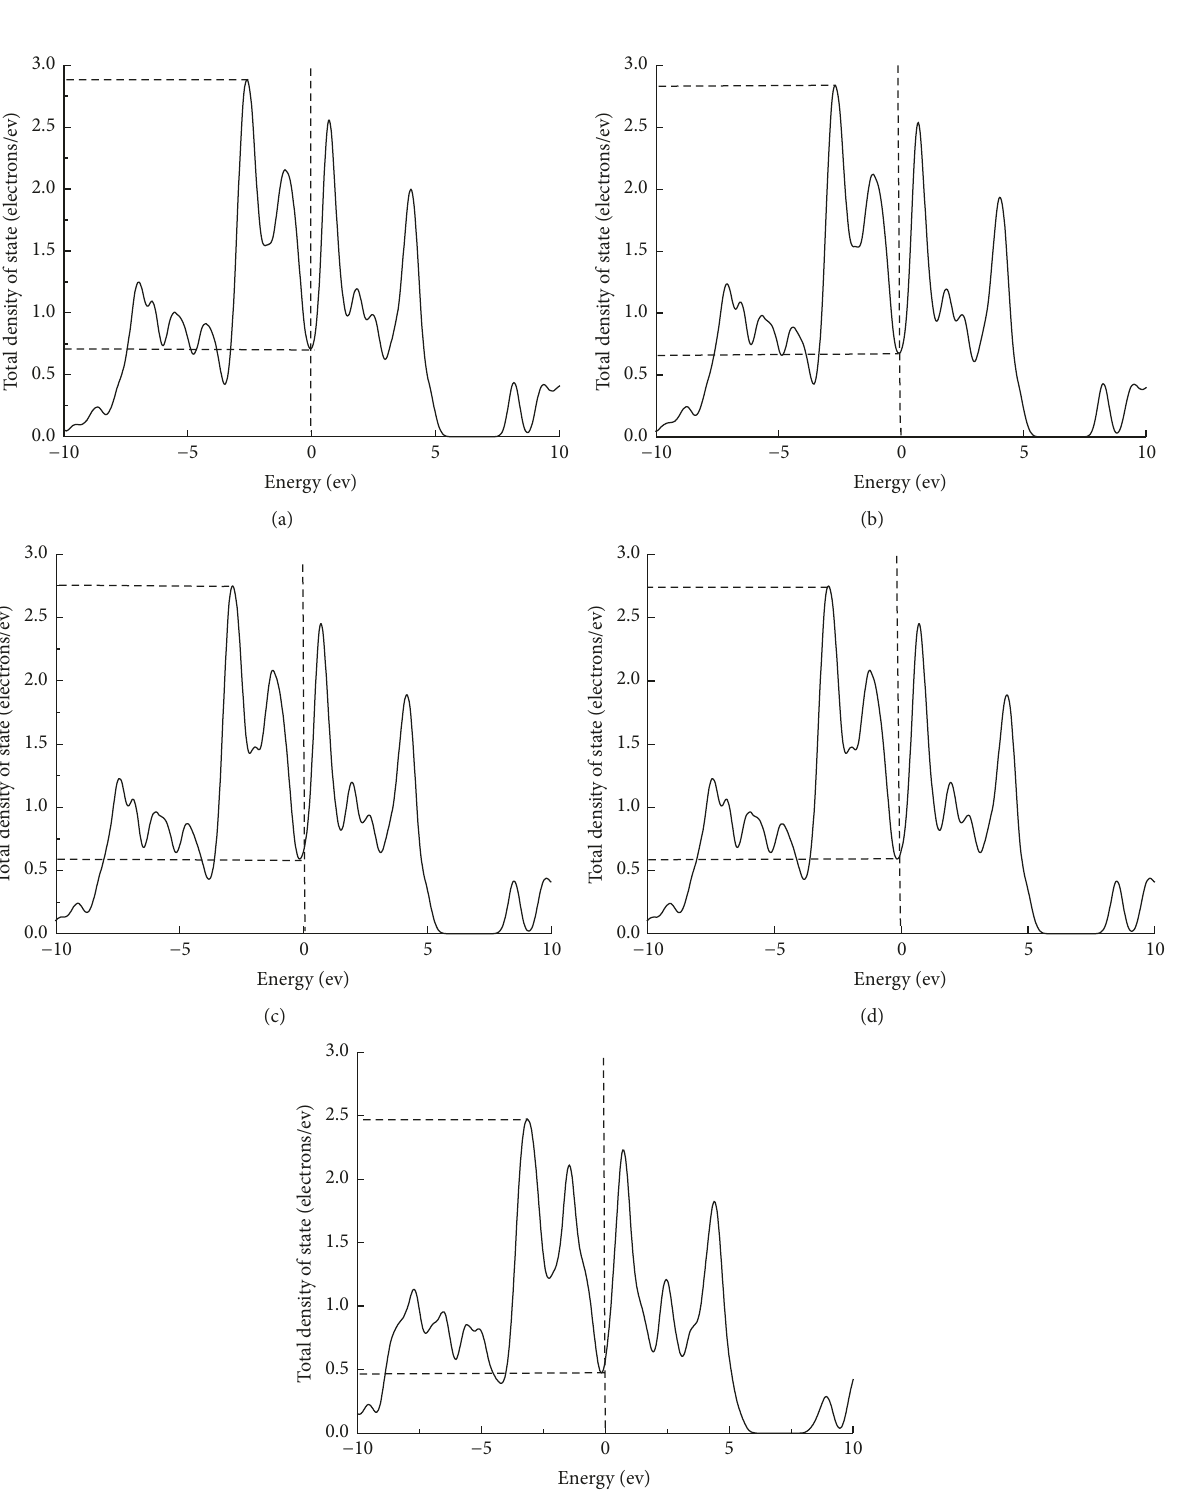
Figure 4: Electron density of states: (a) under 0 MPa stress; (b) under 5MPa stress; (c) under 10MPa stress; (d) under 15MPa stress; (e) under 20 MPa